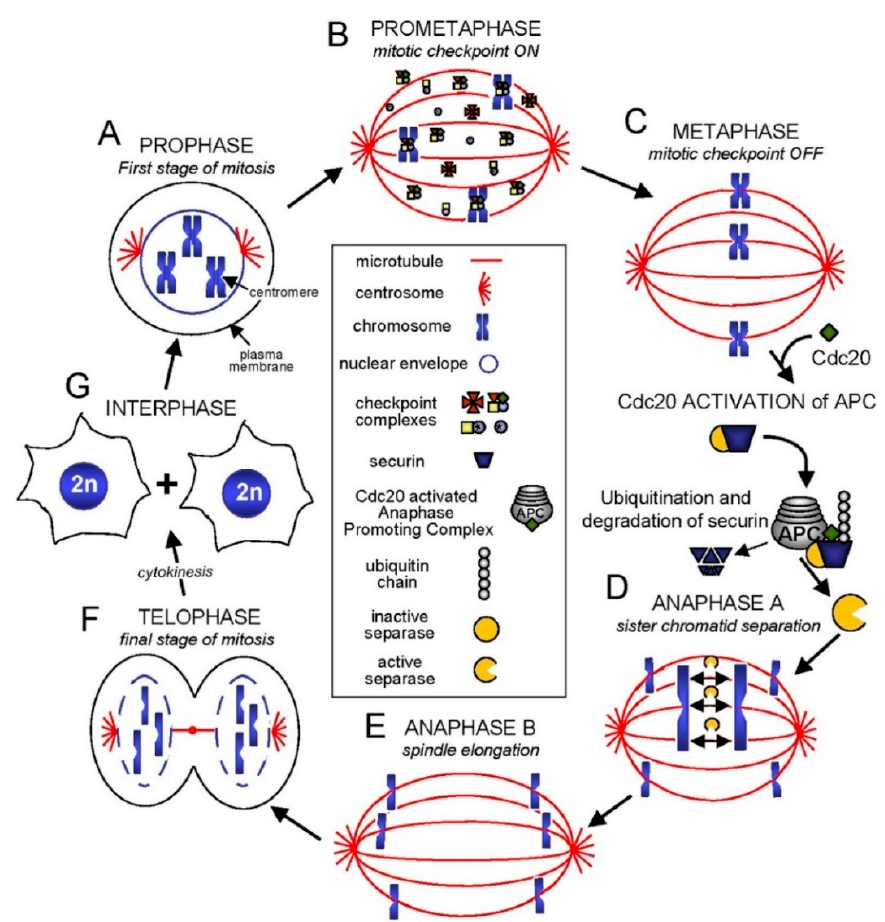
Figure 2. Schematics depicting the phases of mitosis. Reproduced with permission from ref.